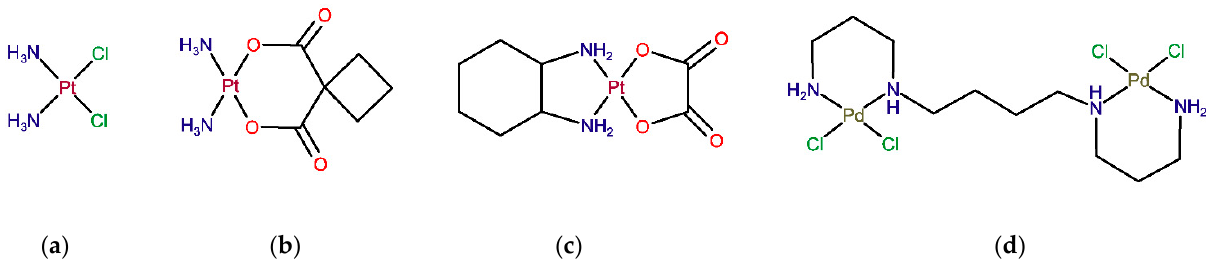
Figure 1. Structure of Pt(II)- and Pd(II)-based agents: Worldwide approved Pt drugs—( a ) cisplatin, ( b ) carboplatin and ( c ) oxaliplatin. ( d ) Novel palladium(II)-based complex Pd 2 Spm.